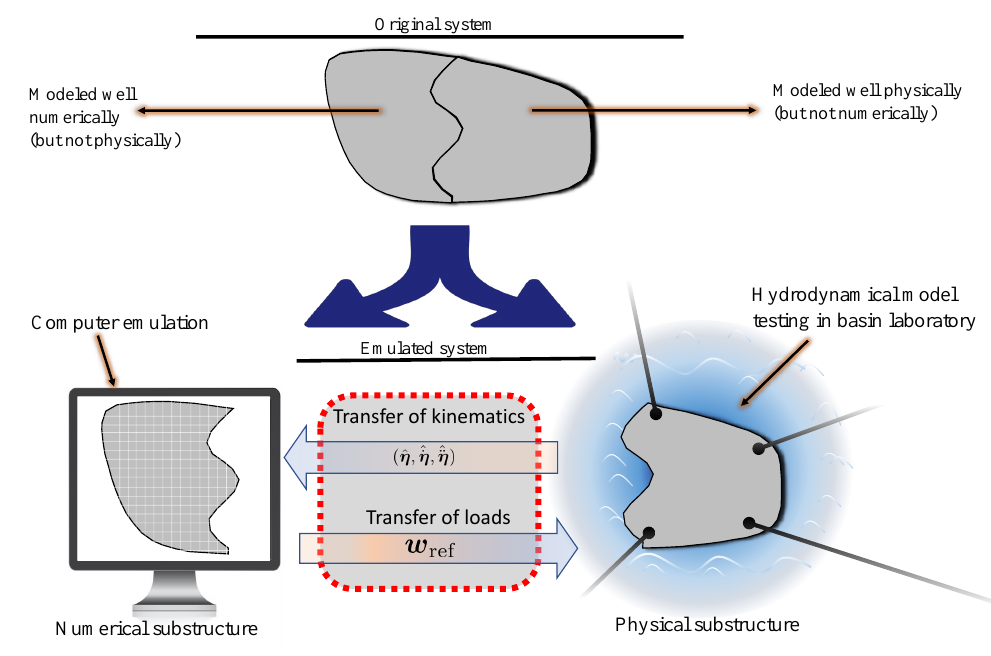
Figure 1. ReaTHM testing of an ocean structure. ω ( · ) represents environmental loads acting on the structure.